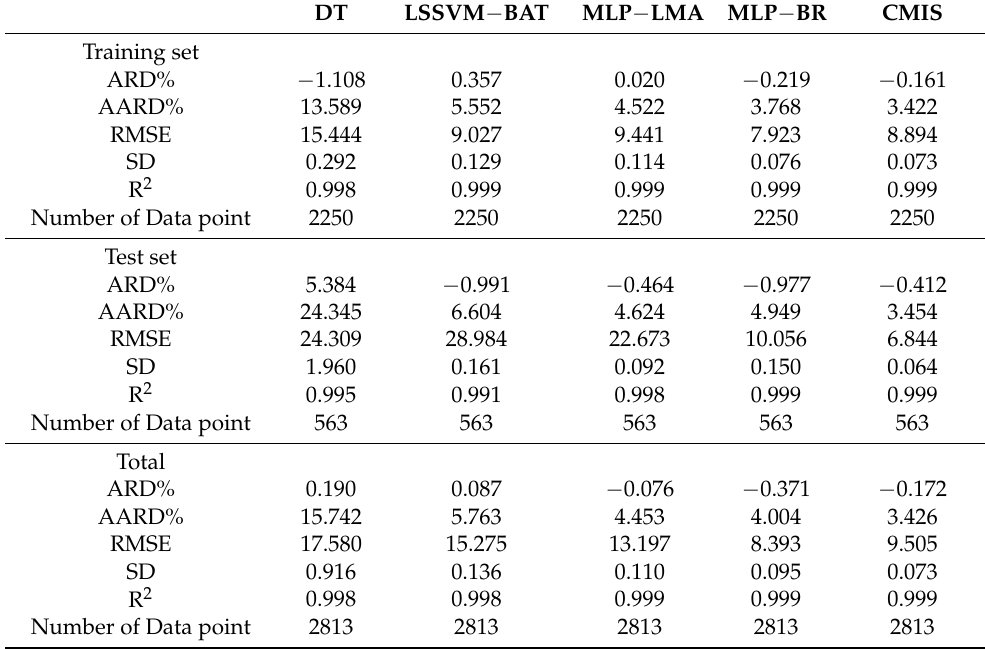
Table 4. Statistical parameters of the developed models for prediction of the viscosity of ILs based on Model